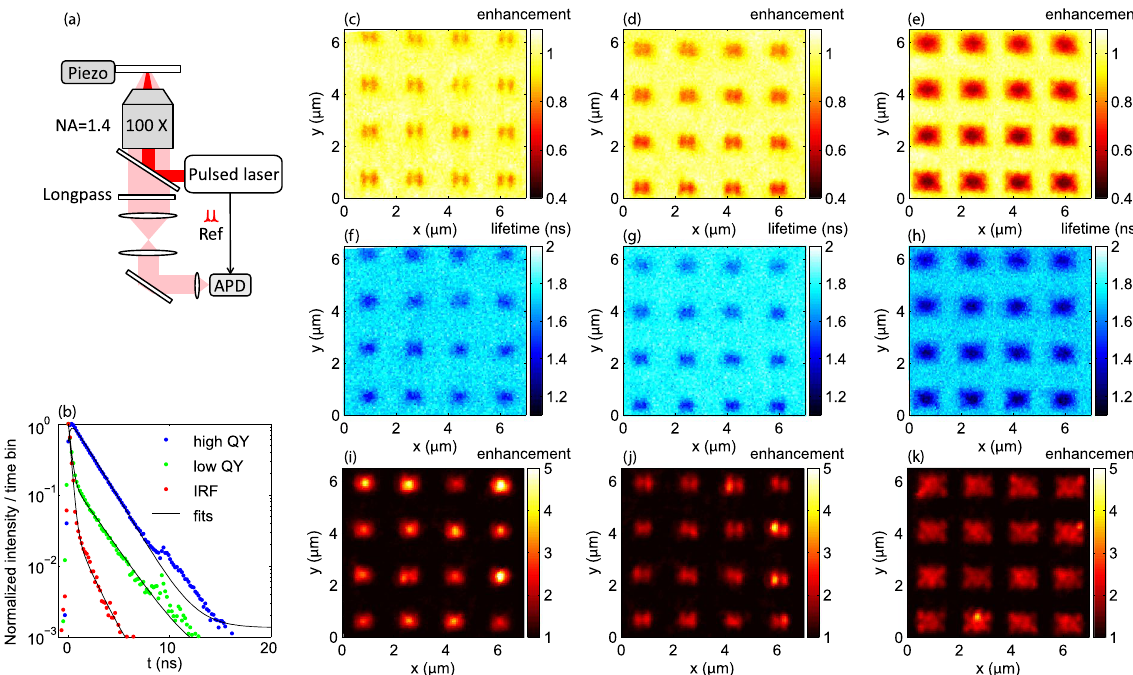
Figure 6. ( a ) A schematic of the confocal time-correlated single-photon counting setup for PL measurements. ( b ) Measured decay curves of the baked and unbaked dye layers, IRF of the laser and the fits to them. ( c – e ) PL enhancement and ( f – h ) lifetime measured from unbaked dye layers on ( c , f ) the pentamer, ( d , g ) first and ( e , h ) second generation of dendritic antennas. ( i – k ) PL enhancement measured from baked dye layers on ( i ) the pentamer, ( j ) first and ( k ) second generation of dendritic